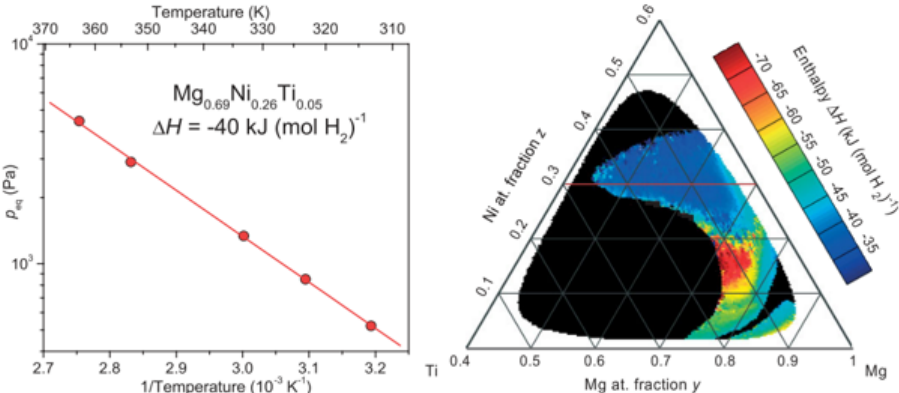
Figure 9. Diagram of enthalpy change of Mg 0.69 Ni 0.26 Ti 0.05 film and Mg y Ni z Ti 1–y–z gradient film. (Reproduced with permission from ref. [132]. Copyright 2007 John Wiley and Sons).